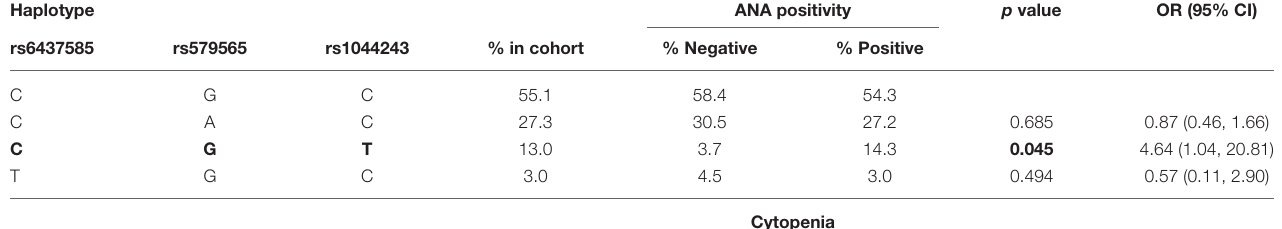
TABLE 6 | Logistic regression analysis of CD166/ALCAM haplotype association with anti-nuclear antibodies (ANA), cytopenia, anemia, lymphopenia, peripheral nervous system (PNS) ESSDAI activity, and pSS susceptibility. Haplotype ANA